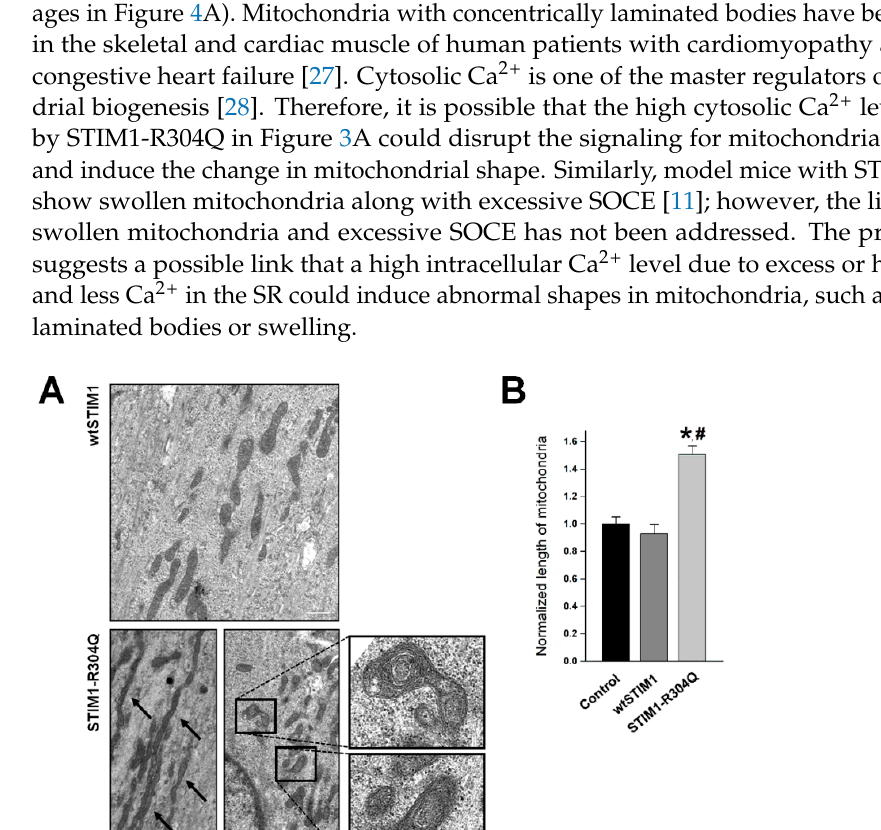
mitochondria could exist by playing a protective role in STIM1-R304Q-expressing myo- tubes. This study was focused on the pathological mechanism of STIM1-R304Q (which is a gain-of-function mutant of STIM1 (i.e., hyper-SOCE) that causes muscle weakness, my- algia, muscle stiffness, and contractures). In our previous study, the pathological prop- erty of R429C (which is a loss-of-function mutant of STIM1 (i.e., null-SOCE) and causes human muscular hypotonia) was examined [7]. Surprisingly, these two opposite mu- tants, in terms of mediating SOCE, have similar characteristics in their tendency in in-